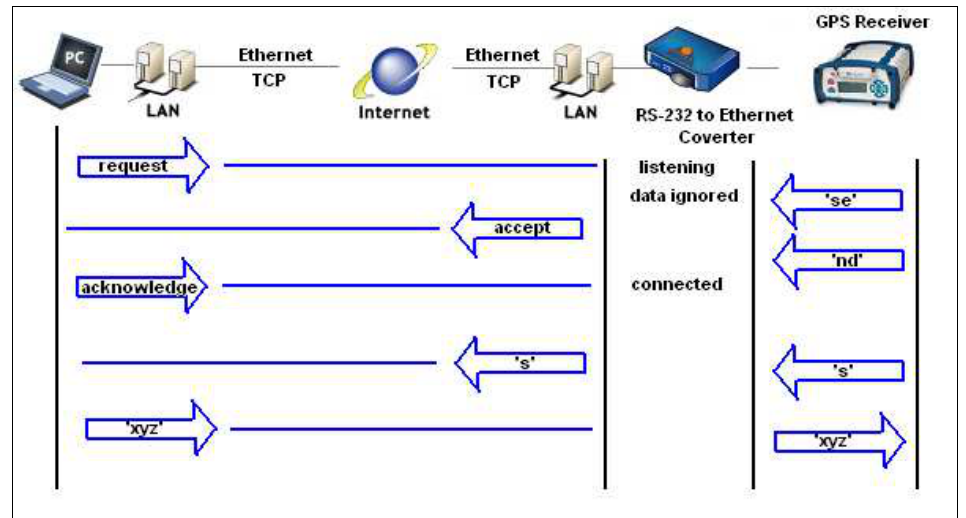
Figure 9. TCP Data Transfer Sequence (based upon